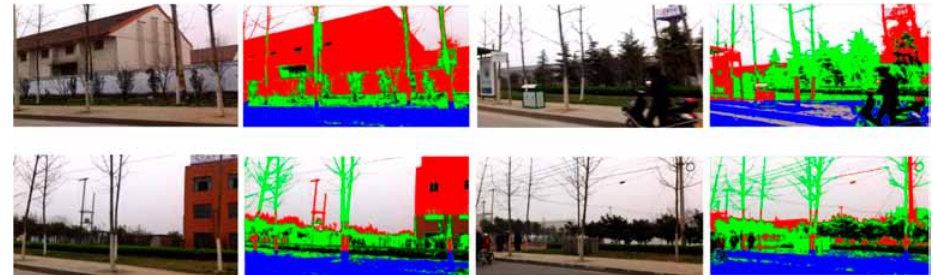
Fig. 3. Contrast images of the actual video-captured images and colour characteristics of landscape elements of industrial